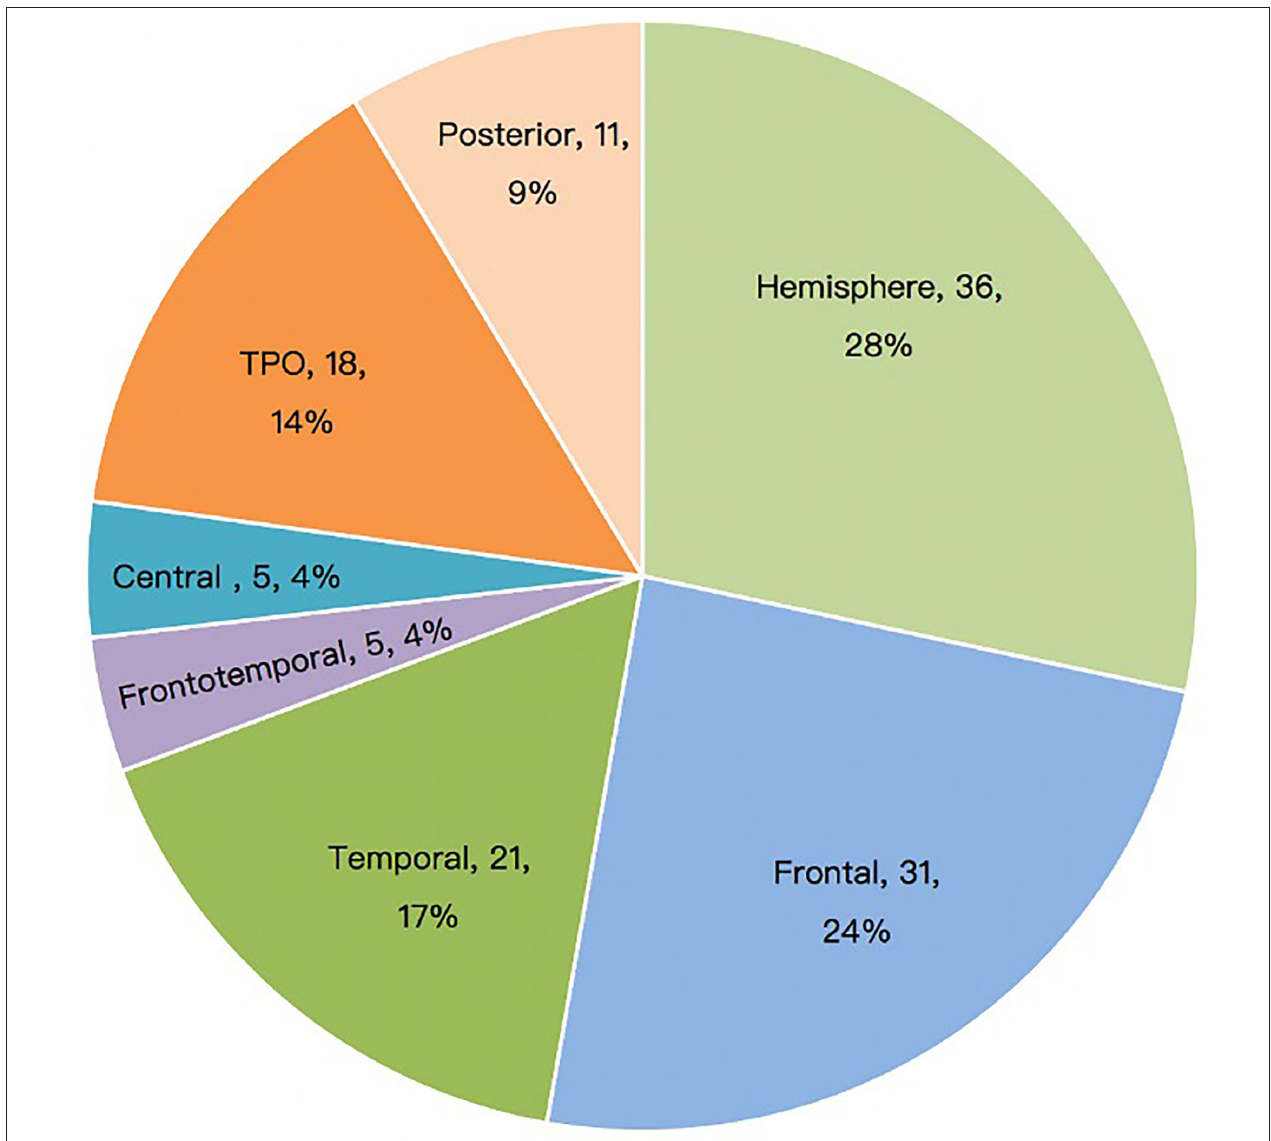
FIGURE 1 | Surgical sites of patients with epileptic spasm ( n = 127). TPO,